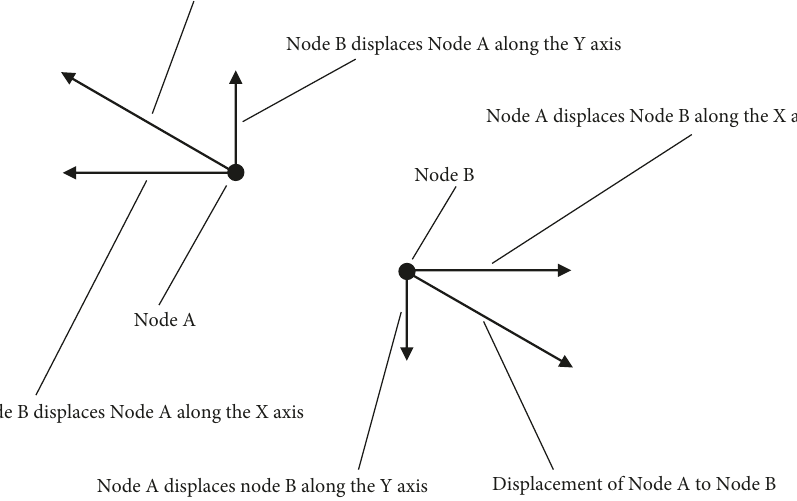
Figure 2: Movement effect caused by the interaction between